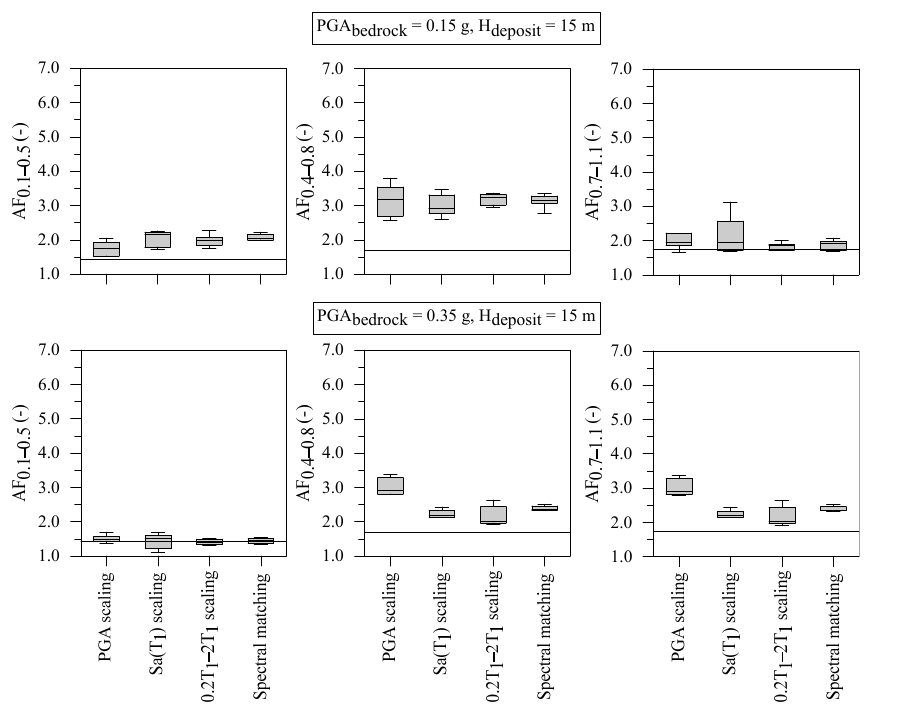
Figure 14. Box plots of AFs for a deposit thickness equal to 15 m and VS 2 (z), considering 4 selection strategies for the input motions. The constant value retrieved from EC8 (thin black line) refers to ground type E.